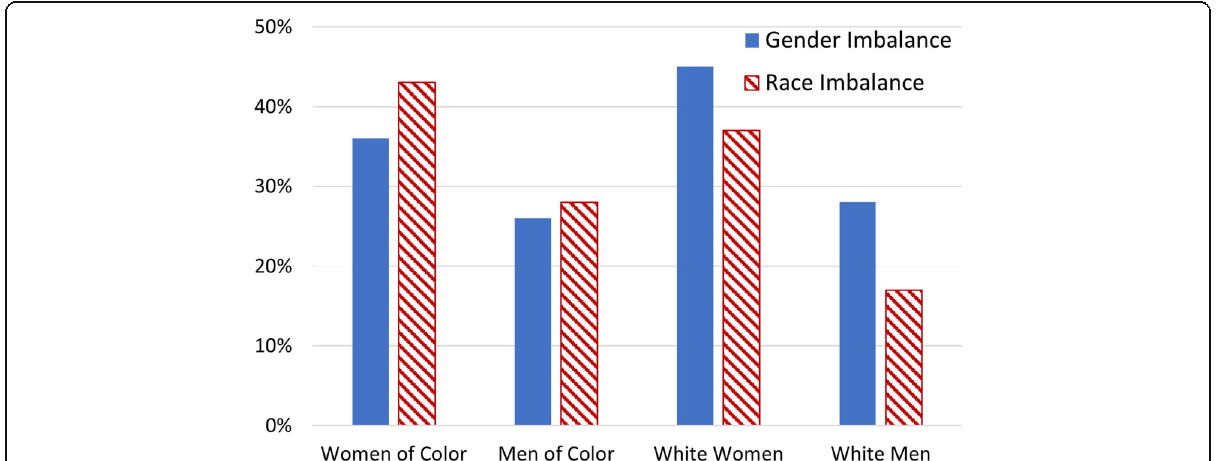
Fig. 4 Percent respondents who cited gender and race imbalance in STEM as a factor contributing to different experiences for women and people of color, by respondents ’ own race-by-gender